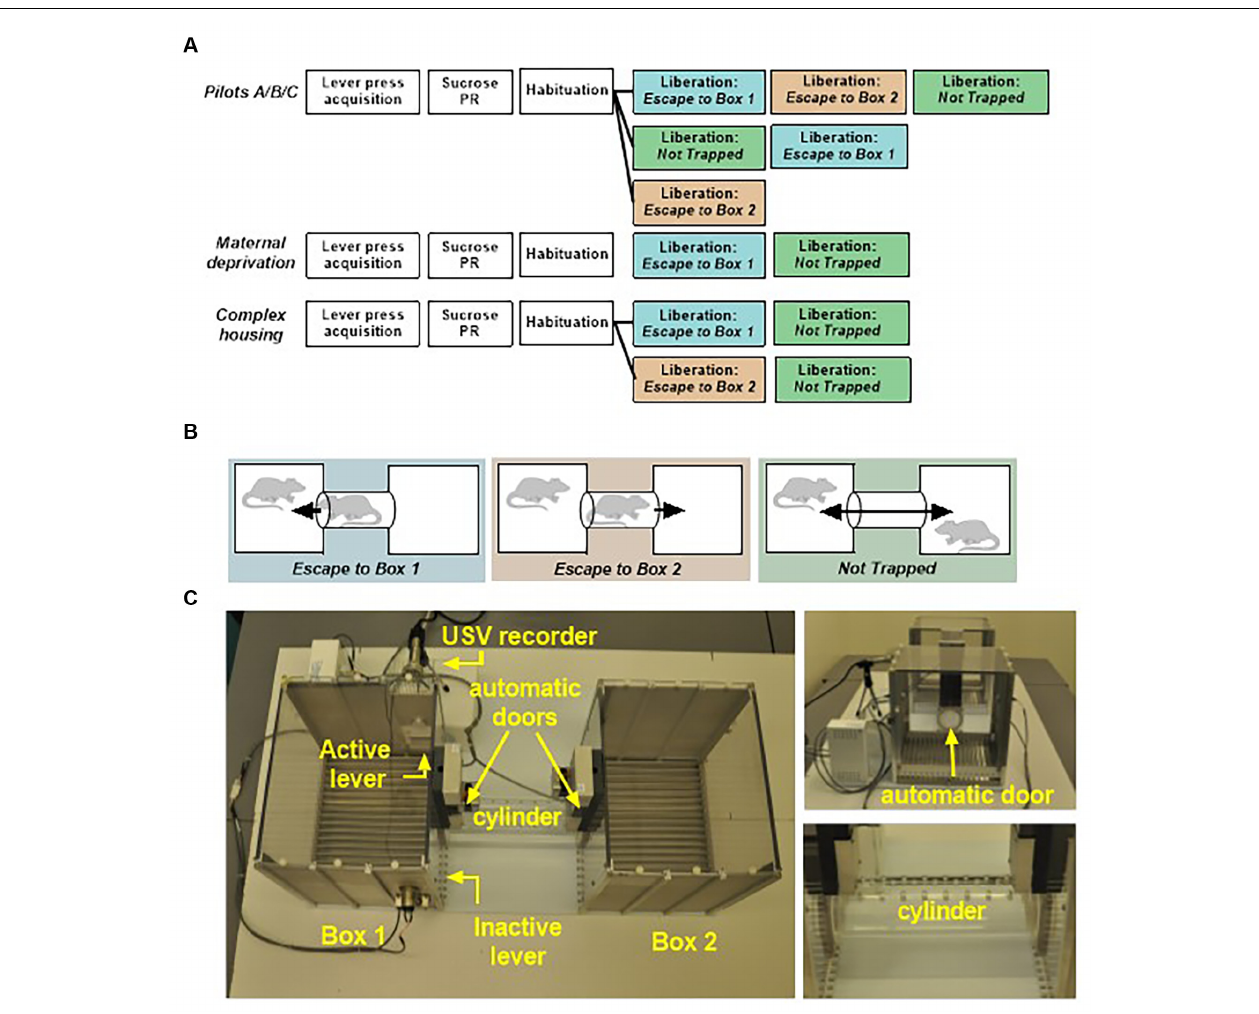
FIGURE 1 | (A) Schematic overview of the behavioral protocols used in the pilots, the maternal deprivation experiment and the complex housing experiment. PR, progressive ratio. (B) Three different configurations in the liberation task were tested: (1) Escape To Box 1 in which the partner was trapped in the cylinder and could be liberated from the cylinder into box 1 (the test rat compartment), (2) Escape To Box 2 in which the partner was trapped in the cylinder and could be liberated into box 2, and (3) Not Trapped configuration in which the partner was situated in box 2 and lever presses of the test rat opened both doors. (C) Liberation task set-up: two operant chambers are connected through a removable cylinder. The cylinder can be closed on both sides by automated mechanical doors made of transparent Plexiglas with holes that allowed rats to see, smell and hear, but not touch each